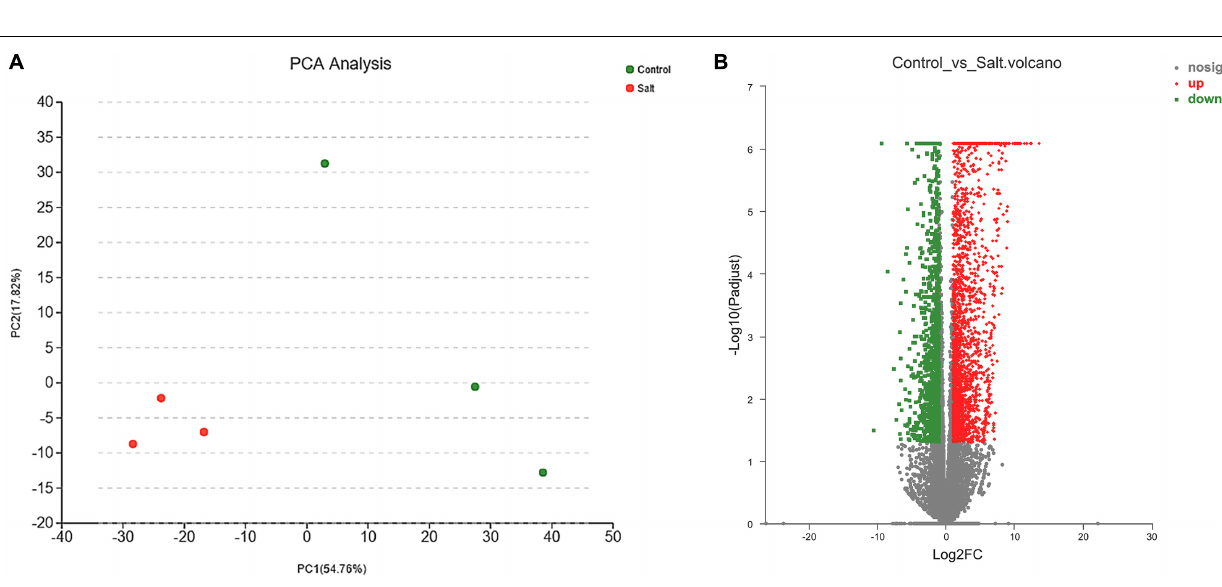
Frontiers in Plant Science |